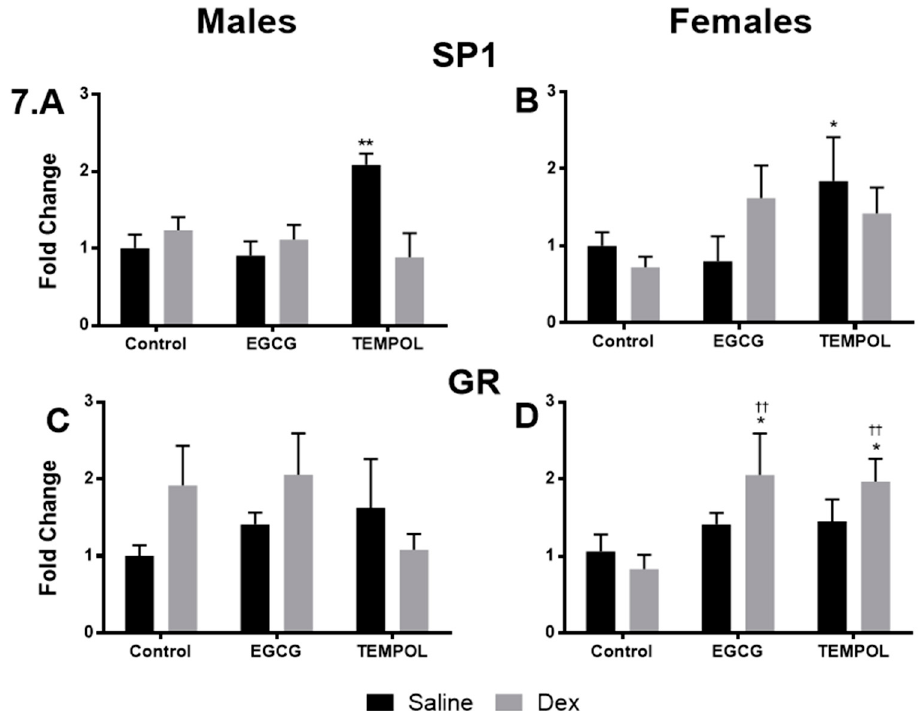
Figure 7. Quantification of transcription factor protein level from offspring adrenal gland. Results of western blot for male and female specificity protein 1 (SP1) ( A , B ) and glucocorticoid receptor (GR) ( C , D ) exposed to TEMPOL or EGCG in utero. Saline and Dex control have been published previously and have been provided for reference [7]. Statistical analysis was performed using a two-way ANOVA (Fisher’s LSD test) shown as * p ≤ 0.05, **/†† p ≤ 0.01. Data are presented as mean ± SEM. Comparison to the Control-Saline group is represented with the symbol (*) and (†) for the Control-Dex offspring n = 4–6 per group. Significant interactions between maternal injection and antioxidant administration were found for SP1 males.